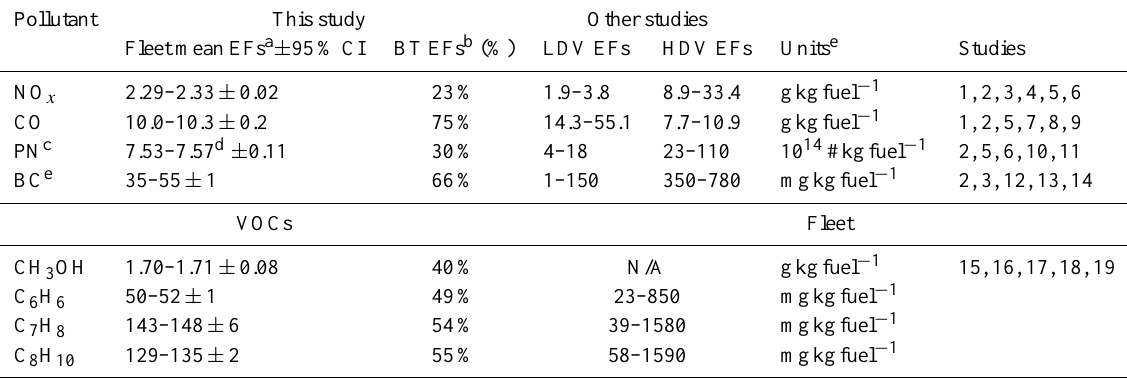
Table 2. Fleet mean EFs from this study, including percentage of BT EFs, compared with the range of LDV, HDV and fleet EFs reported from other real-world fuel-based EF studies. Emission factors in km − 1 distance-based units in the Supplement (Table S4). Pollutant This study Other studies